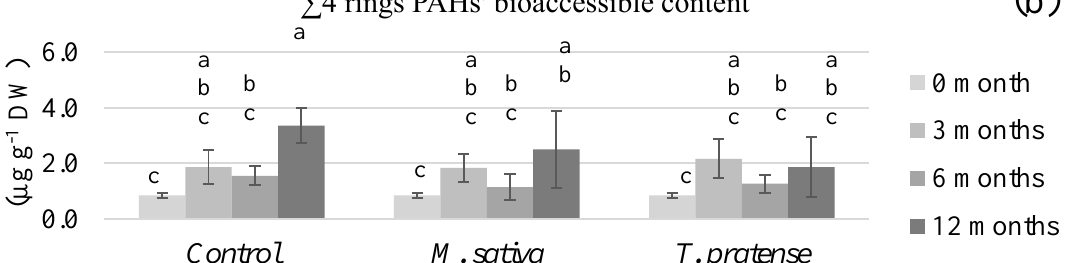
Figure 4. The intermediate PAHs’ (∑4 rings) ( a ) residual and ( b ) bioaccessible content of soils planted with M. sativa L. or T. pratense L. compared to unplanted control samples after different time periods. The values are means ± confidence interval (α = 5%, n = 5). There is a significant interaction between the type and the time of culture, so within each PAH fraction (residual or bioaccessible) sticks that share the same letter are not significantly different ( p > 0.05).